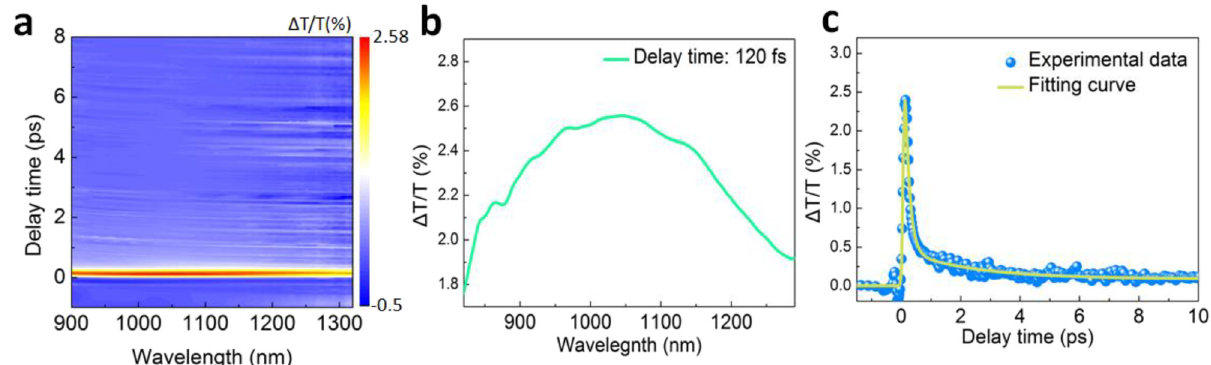
Figure 4: (a) Differential transitivity spectra of MXene versus long wavelength of probe light and delay time at the near-infrared region. (b)DifferentialtransitivityspectraoftheMXeneatthedelaytimeof t =120fs.(c)Thedynamiccurvesand fi